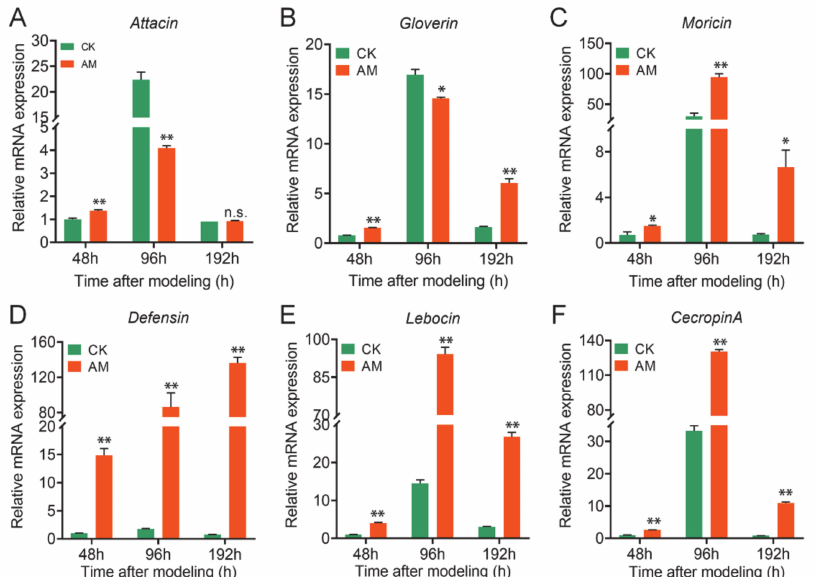
Figure 3. High PPC induced AMPs upregulation in fat body. ( A – F ) mRNA levels of AMP genes in fat body from silkworm at 48–192 h after modeling. * p < 0.05; ** p < 0.01; n.s., no significant difference between the two groups. Mean ± SEM. n =